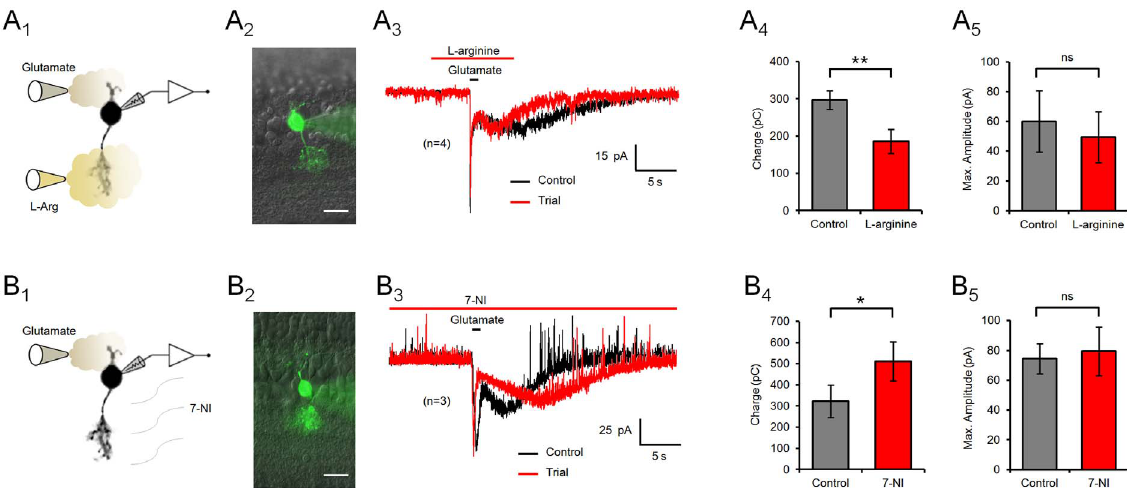
Figure 4. Endogenous NO modulates the time-course of the slow component of the glutamate response. (A) Perfusion of the axonal terminals of type 4 CBCs with the NO precursor L-arginine (1 mM) significantly shortened the slow component of the glutamate response (A 3 ) and reduced the overall charge transferred during the response (A 4 ), while the maximum response amplitude was unaffected (A 5 ). (B) On the other hand, bath perfusion of retinal slices with the NO synthase inhibitor 7-NI (100 m M) significantly increased the charge transferred during the response (B 4 ), but did not have an effect on the